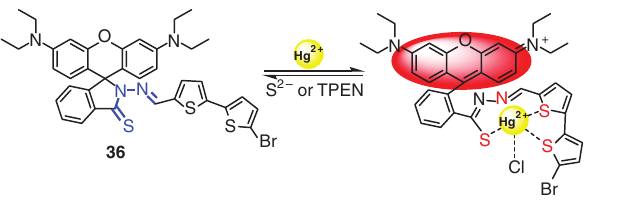
Figure 23: Recognition mechanism of probe 36 with Hg 2 + .